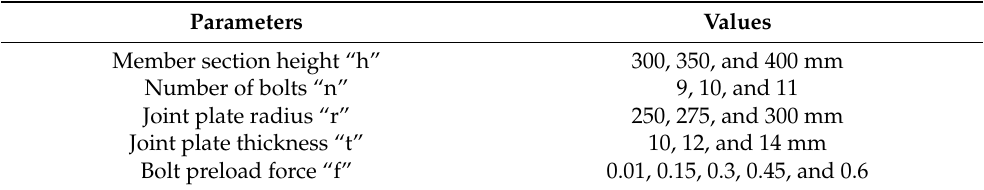
Table 1. Geometric dimensions of AAG